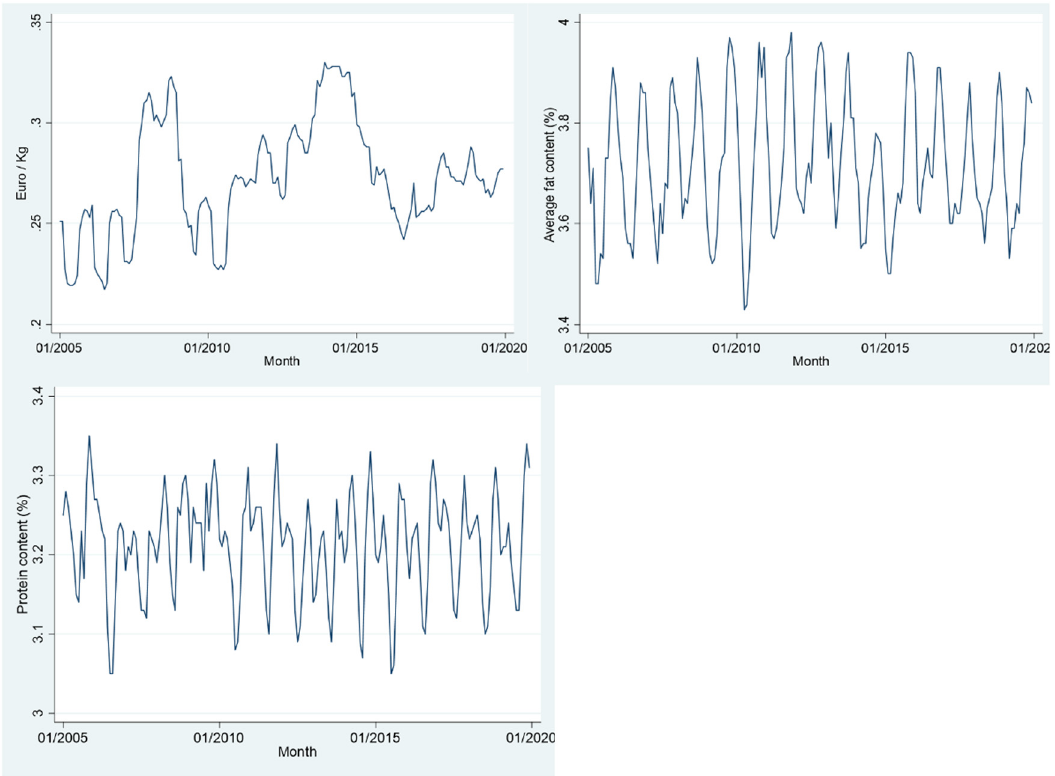
Figure 4: Average monthly prices and characteristics ( 2005 – 2019 ) in the Azores for milk purchased from individual producers ( producers deliver to reception stations at the factory; transport is charged for by the producer )